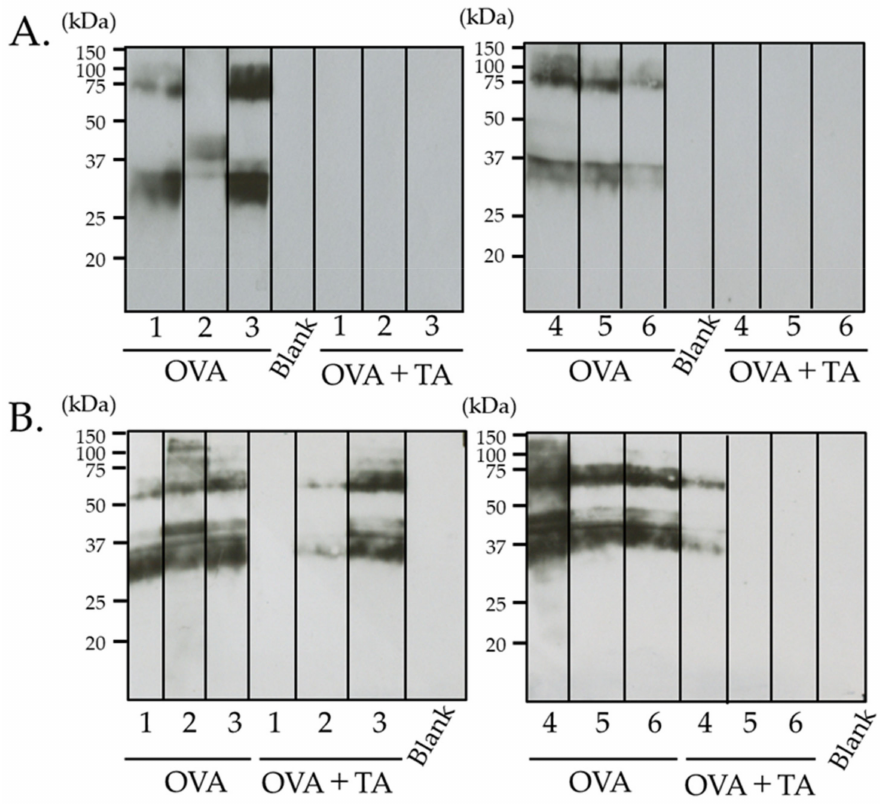
Figure 4. Immunoblotting analysis of IgG1-binding protein bands. Immunoblotting using OVA proteins, individual mice sera at ( A ) 3 w and ( B ) 4 w, and HRP-labeled anti-mouse IgG1 antibody. The numbers indicate the individual mice in the OVA and OVA + TA groups. Molecular mass was expressed in kDa. No specific bands were detected in areas higher or lower than the 15–150 kDa range in sera from mice in both groups (data not